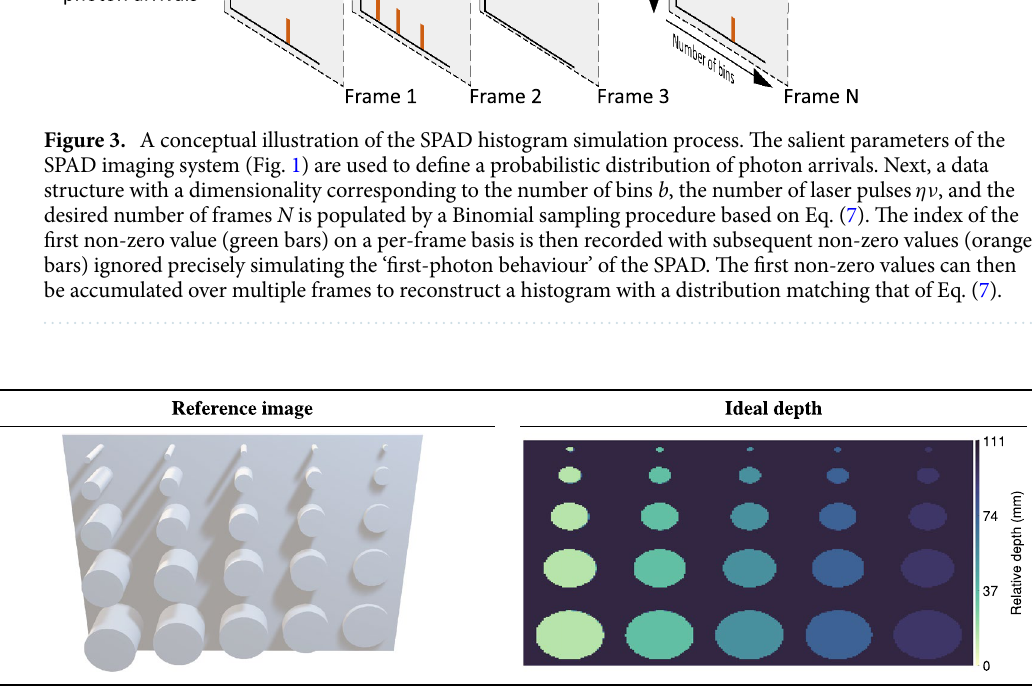
Figure 4. A reference image of the resolution test target. The test target consisted of a series of cylinders ranging in both diameter and height from 90 mm to 10 mm in 20 mm increments. The ground truth depth map for the simulation of the resolution test